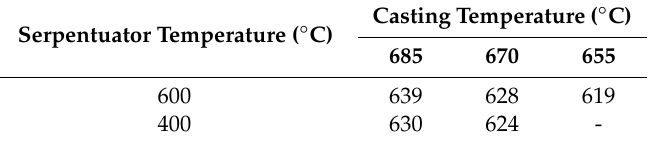
Table 2. Average outlet temperature of the 7075 aluminum alloy flowing through the serpentuator. Casting Temperature ( ◦ C) Serpentuator Temperature ( ◦ C)